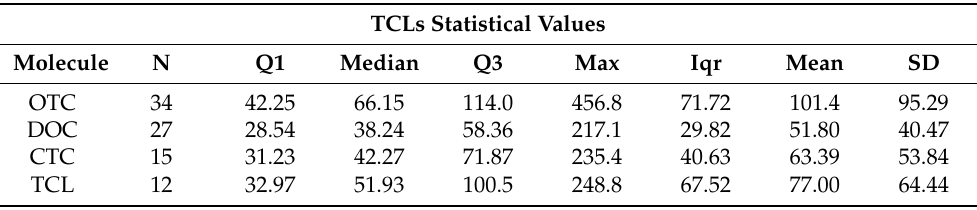
values (Q3), maximum value (Max), interquartile range (iqr), mean, and standard deviation (SD) are statistical values for TCLs. Median, max and mean values are expressed as µ g kg − 1 . N is the